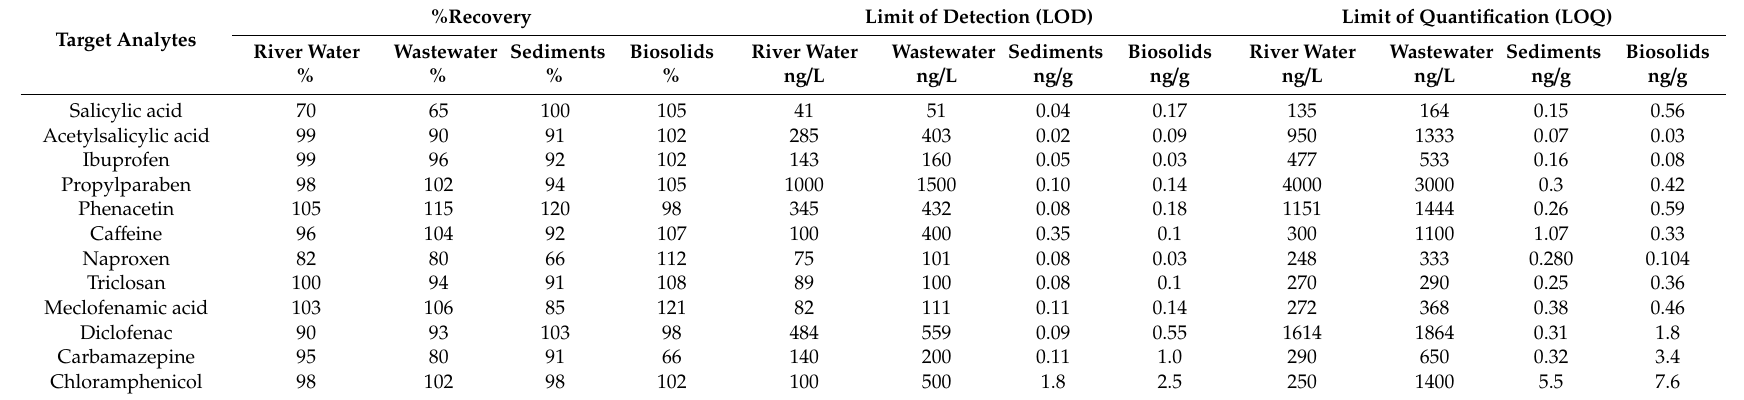
Table 2. Percent recovery, limit of detection and limit of quantification of derivatized compounds after spiking samples and performed